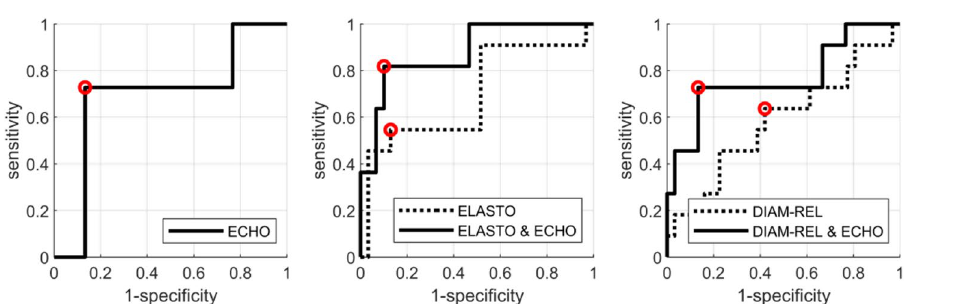
Figure 4. ROC curves for classification of non-responding tumours (RMC ≥ 70%) after the 3rd NAC course. The classifiers were based on ECHO (left), ELASTO alone and with ECHO (middle), and DIAM-REL alone and with ECHO (right). Red markers indicate the operating points for which the parameters are shown in Table 4.